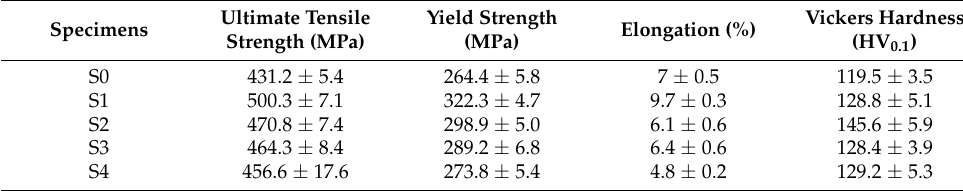
Figure 12. Ultimate tensile strength, yield strength, and elongation data of the SLMed AlSi10Mg and Y 2 O 3 -AlSi10Mg alloy. Table 4. Mechanical properties of SLM-processed specimens.